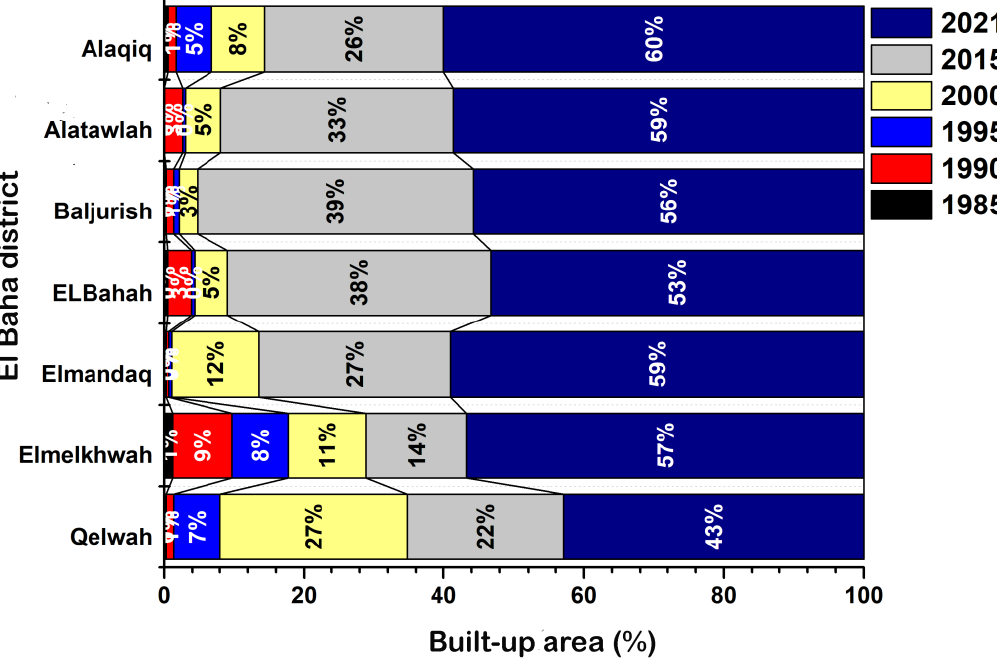
Figure 8. Mapping of built-up area (km 2 ) for the years: 1985, 1990, 1995, 2000, 2015, and 2021.